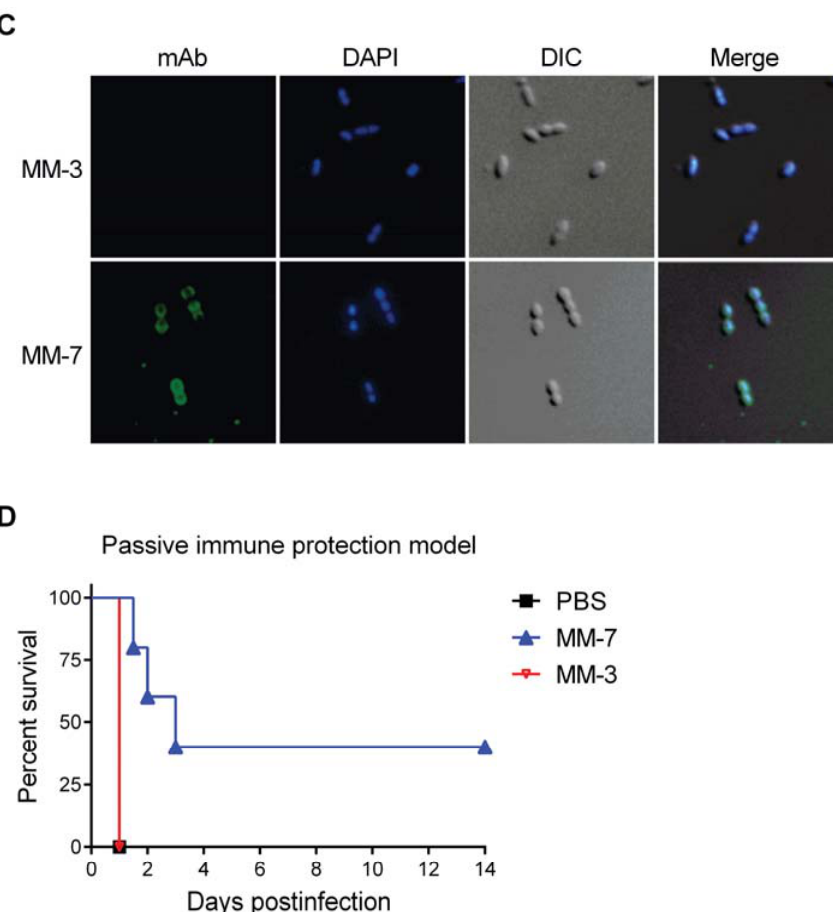
Figure 6. Localization of cross-protective epitopes in PR2. ( A ), Epitope mapping of anti-PR2/N and anti-PR2/C serum antibodies by competition ELISA with peptides representing N- and C-terminal parts of PR2. Immune sera were used at a dilution of 1:100 and the peptide competitors at a concentration of 100, 10 or 0.1 μg/mL; ( B ), Fine mapping of